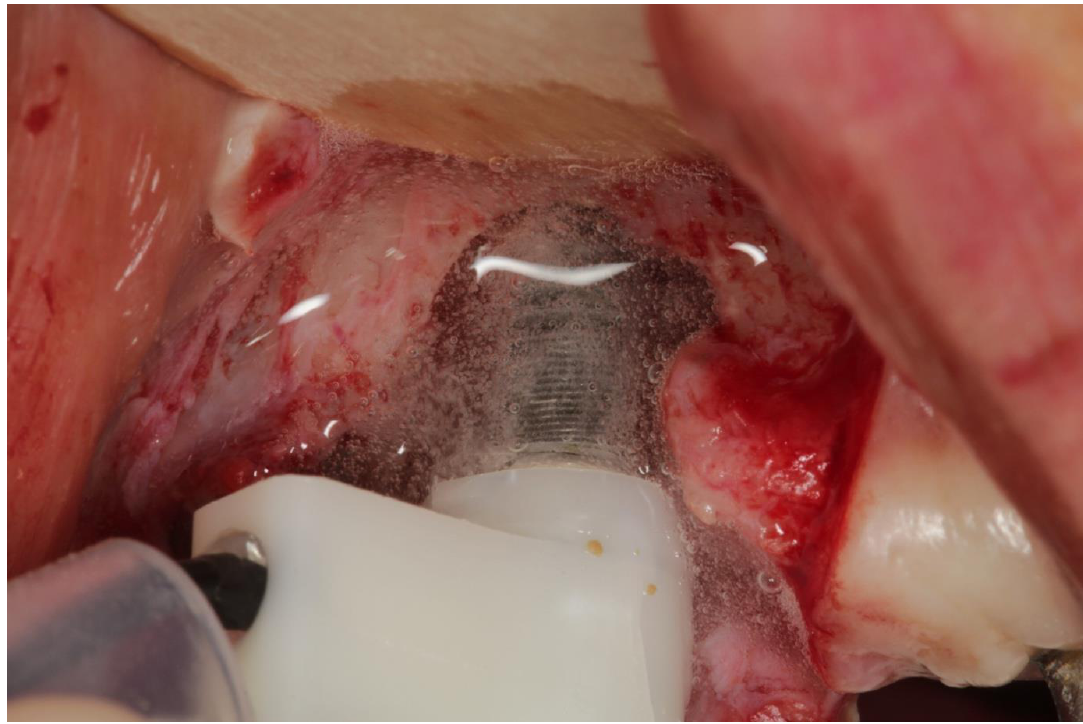
Figure 2. Spray-head during cleaning process. 114